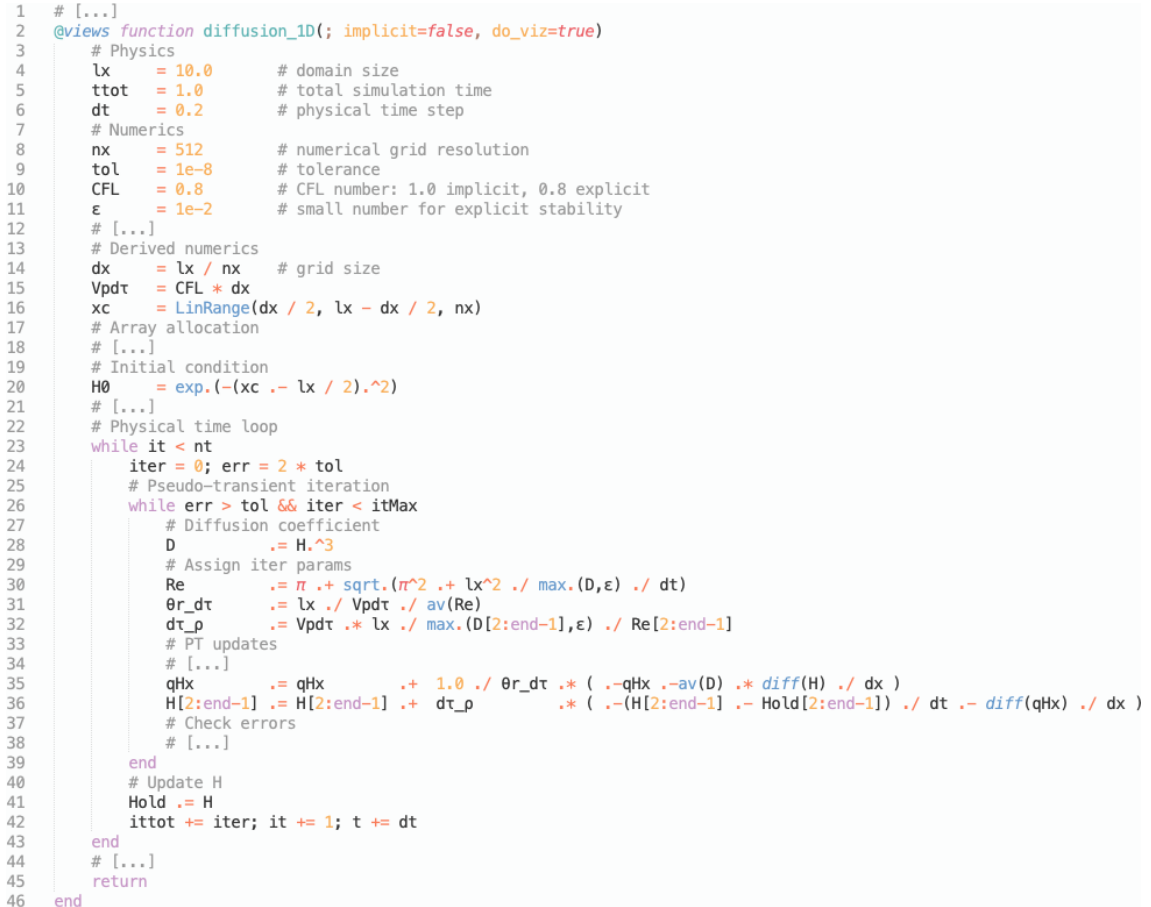
Figure 4. Numerical Julia implementation of the 1D nonlinear diffusion case D = H 3 . Lines marked with # [...] refer to skipped lines. See diff_1D_nonlin_simple.jl script located in the scripts folder in PseudoTransientDiffusion.jl on GitHub for full